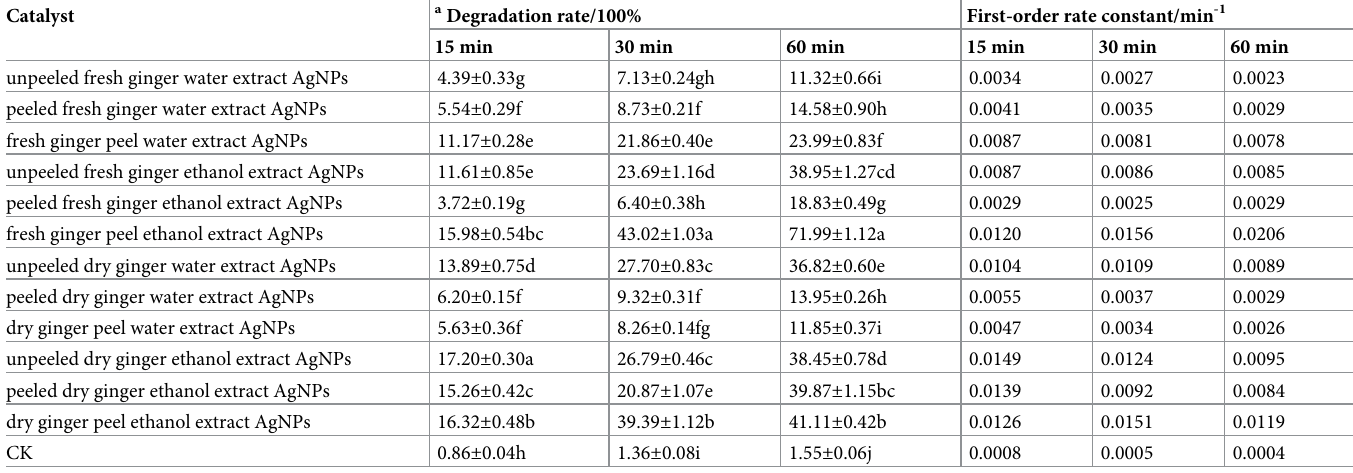
Table 4. Summary of degradation rate percentage and rate constant for degradation of DO26 catalyzed by Z . officinale AgNPs.